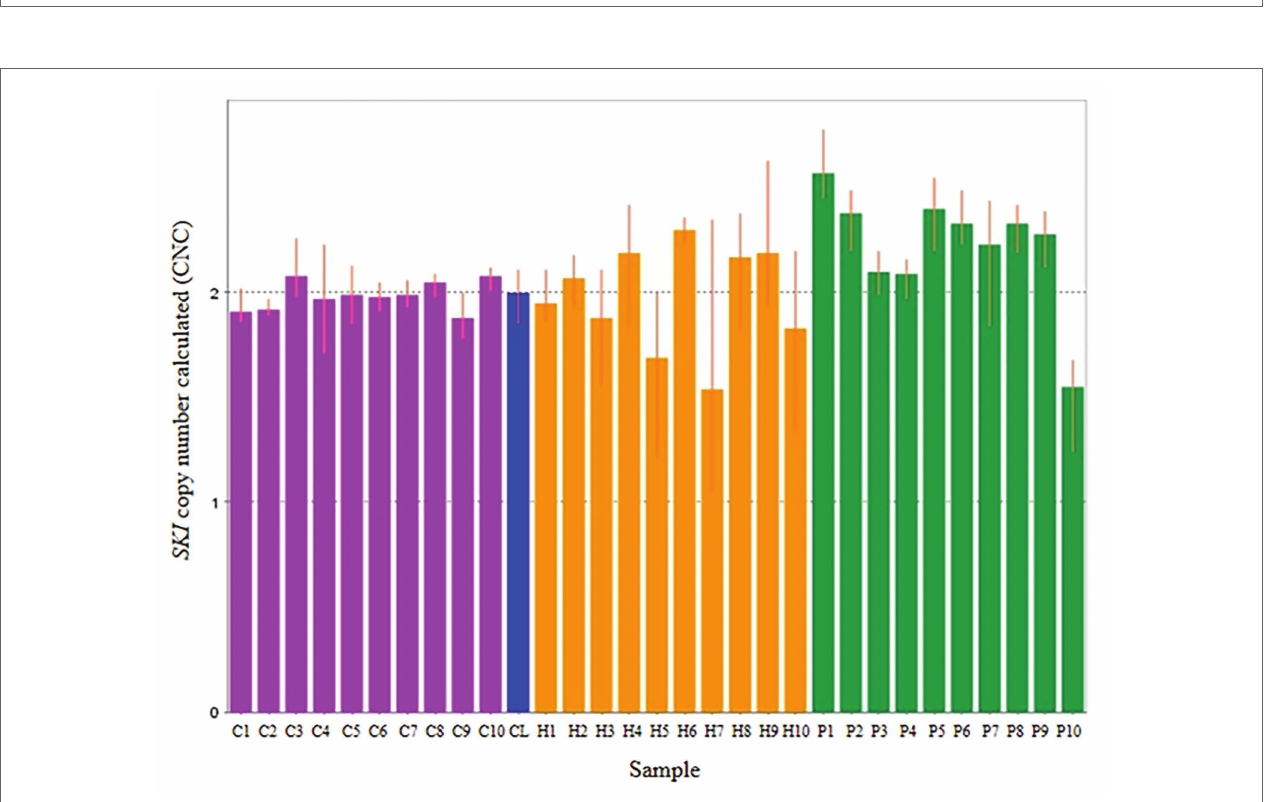
FIGURE 3 | Representative of copy number calculated (CNC) of SKI in normal control (purple bars), non-cleft with hypodontia (yellow bars) NSCL/P with hypodontia (green bars) and calibrator (blue